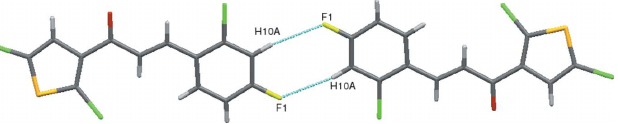
Figure 2 The R 2 (8) ring motif. 2